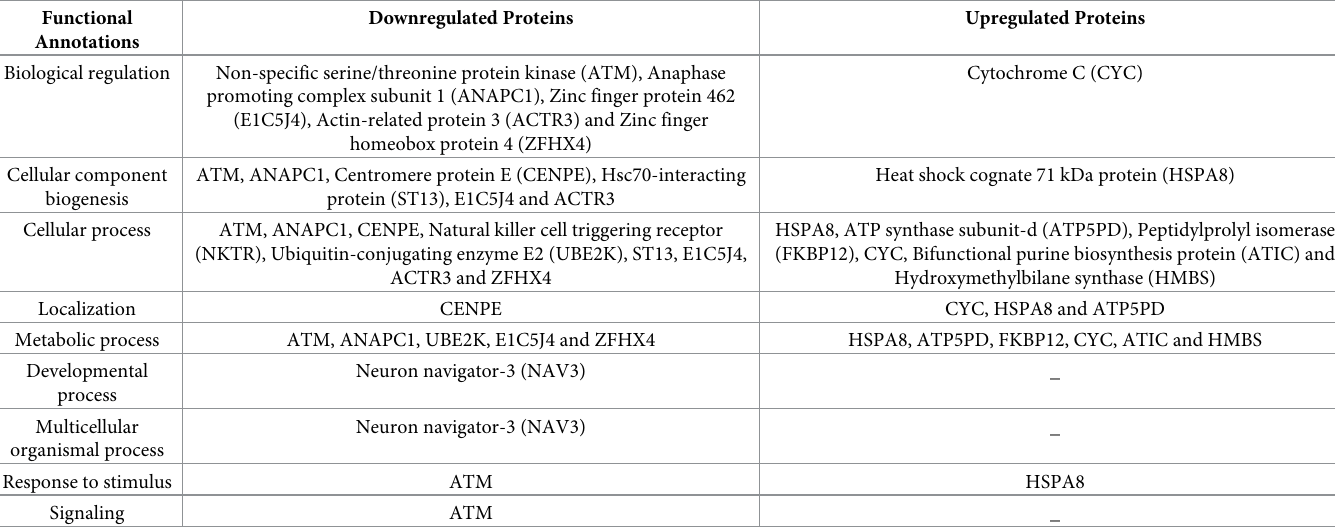
Table 2. Go-annotated proteins associated with different biological processes in HTC infected with S . Enteritidis. Functional Annotations